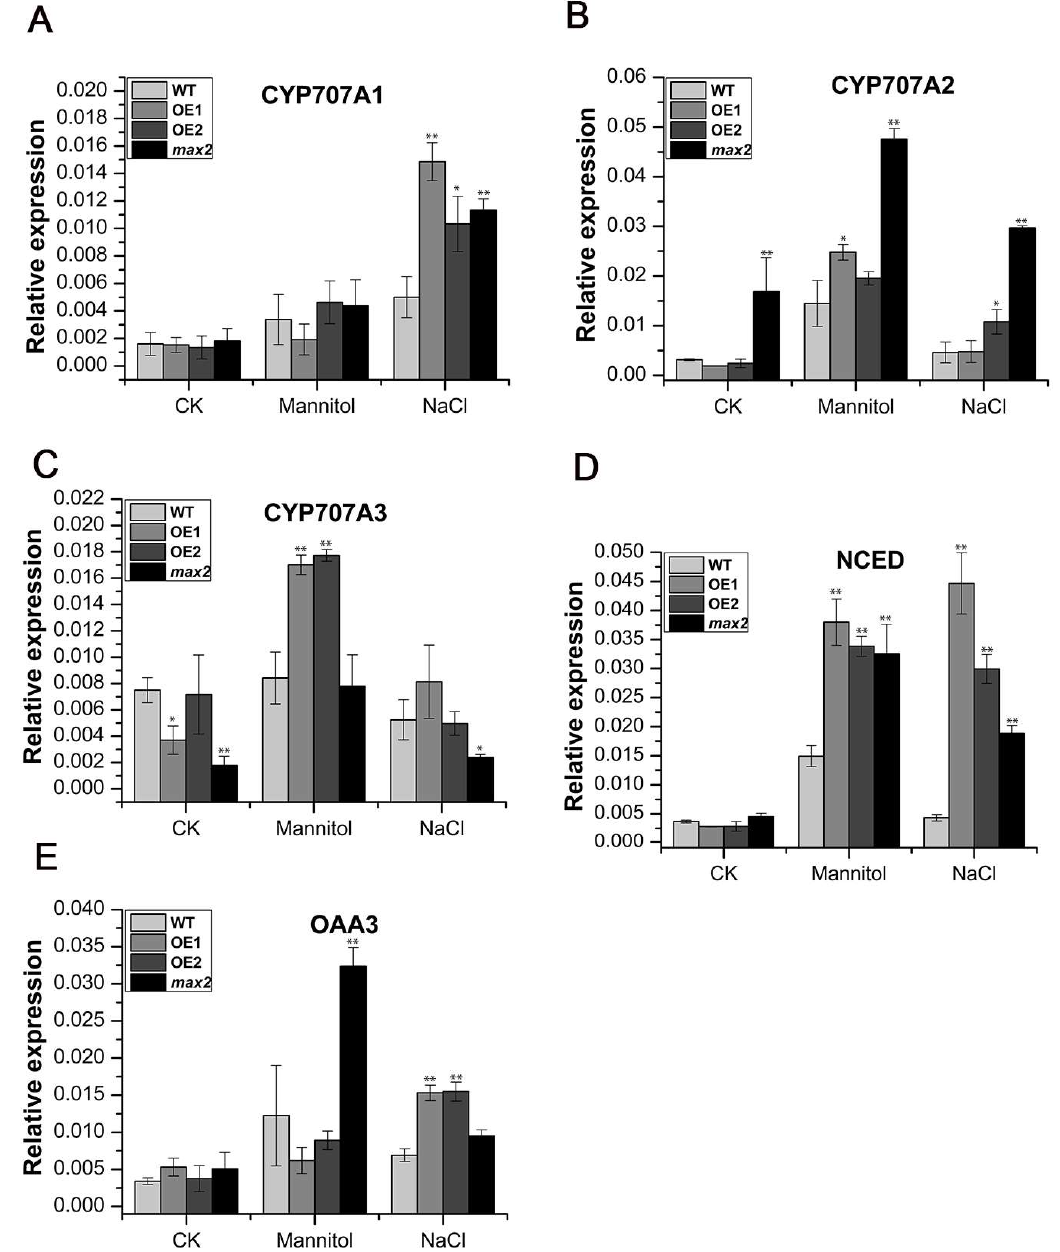
Figure 9. Expression of key ABA biosynthesis genes of the SsMAX2 OE lines, max2 , and WT was diversely regulated in response to salt and osmotic treatment. The gene expression of ( A ) CYP707A1 , ( B ) CYP707A2 , ( C ) CYP707A3 , ( D ) NCED3 , and ( E ) OAA3 was determined at 6 h after mannitol and NaCl treatment by qPCR. SsACT was used as the internal control. Data are presented as means ± SD of three biological replicates. Student’s t -test was used to determine the significant differences between WT and other Arabidopsis lines. Significance level: * p < 0.05, ** p < 0.01.